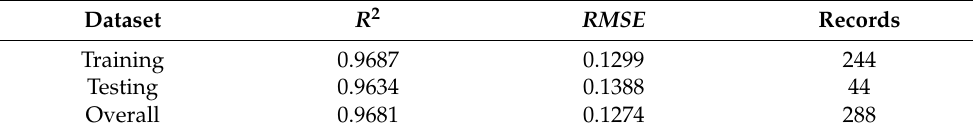
Table 4. Performance of the selected DBN model.